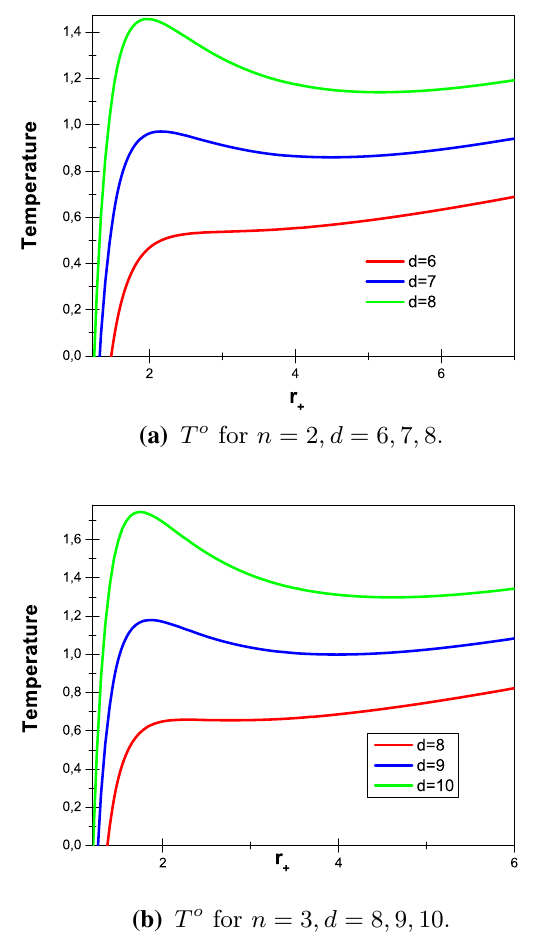
Fig. 4 T o for second family of solutions with toy values of Q = 1 and l = 8